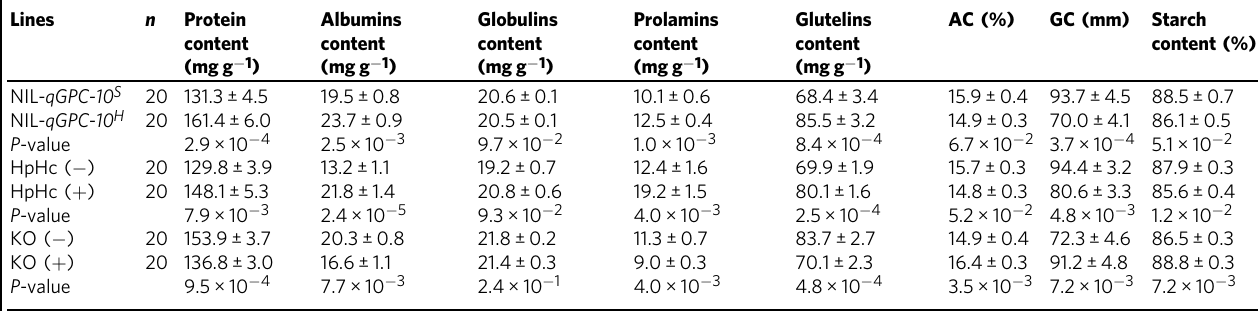
Table 1 Grain quality traits in NILs and transgenic plants Lines